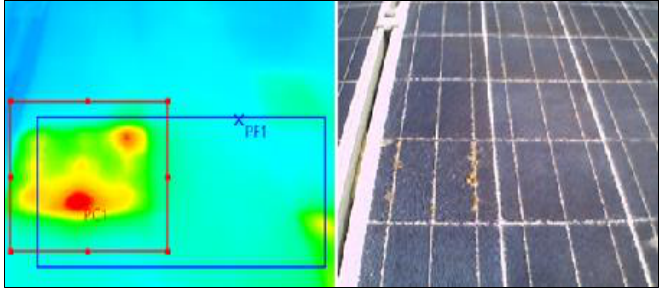
Figure 8: Oxidation of a cell on the edge of a photovoltaic module.